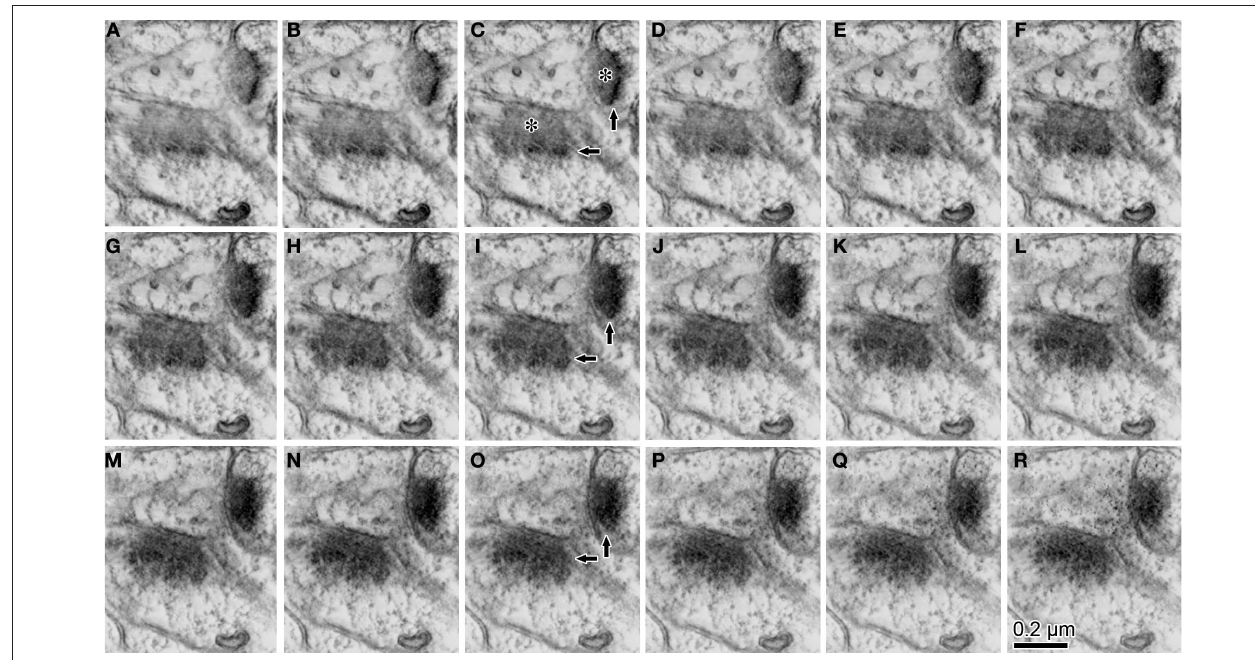
FIGURE 6 | The serial z-slice sections obtained by the tomography analysis showing the postsynaptic dendrite and spine in Figure 3M. We picked up 16 z-slice sections (A–R) of good quality from the middle of the z-slice sequence. The estimated thickness of the z-slice section is 1.75 nm. The Intermediately electron dense fl occulate substance presumably synaptic cleft structure [for example;